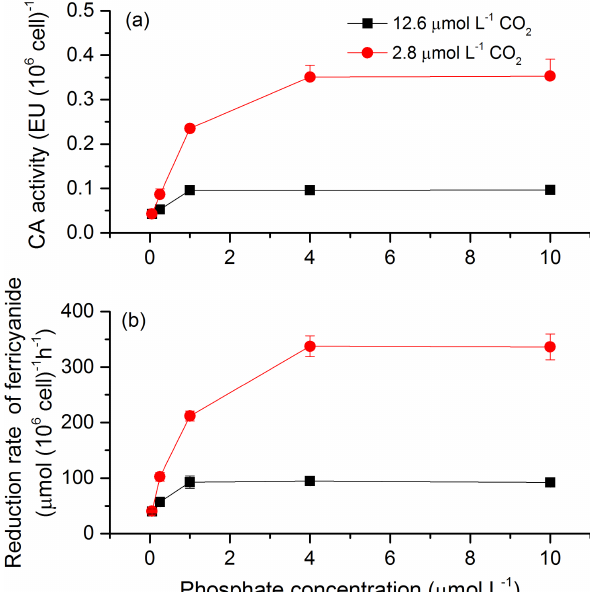
Figure 6. CA ext activity (a) and reduction rate of ferricyanide (b) in S. costatum grown at various phosphate concentrations after 12.6 and 2.8µmol CO 2 treatments. The error bars indicate the standard deviations ( n =